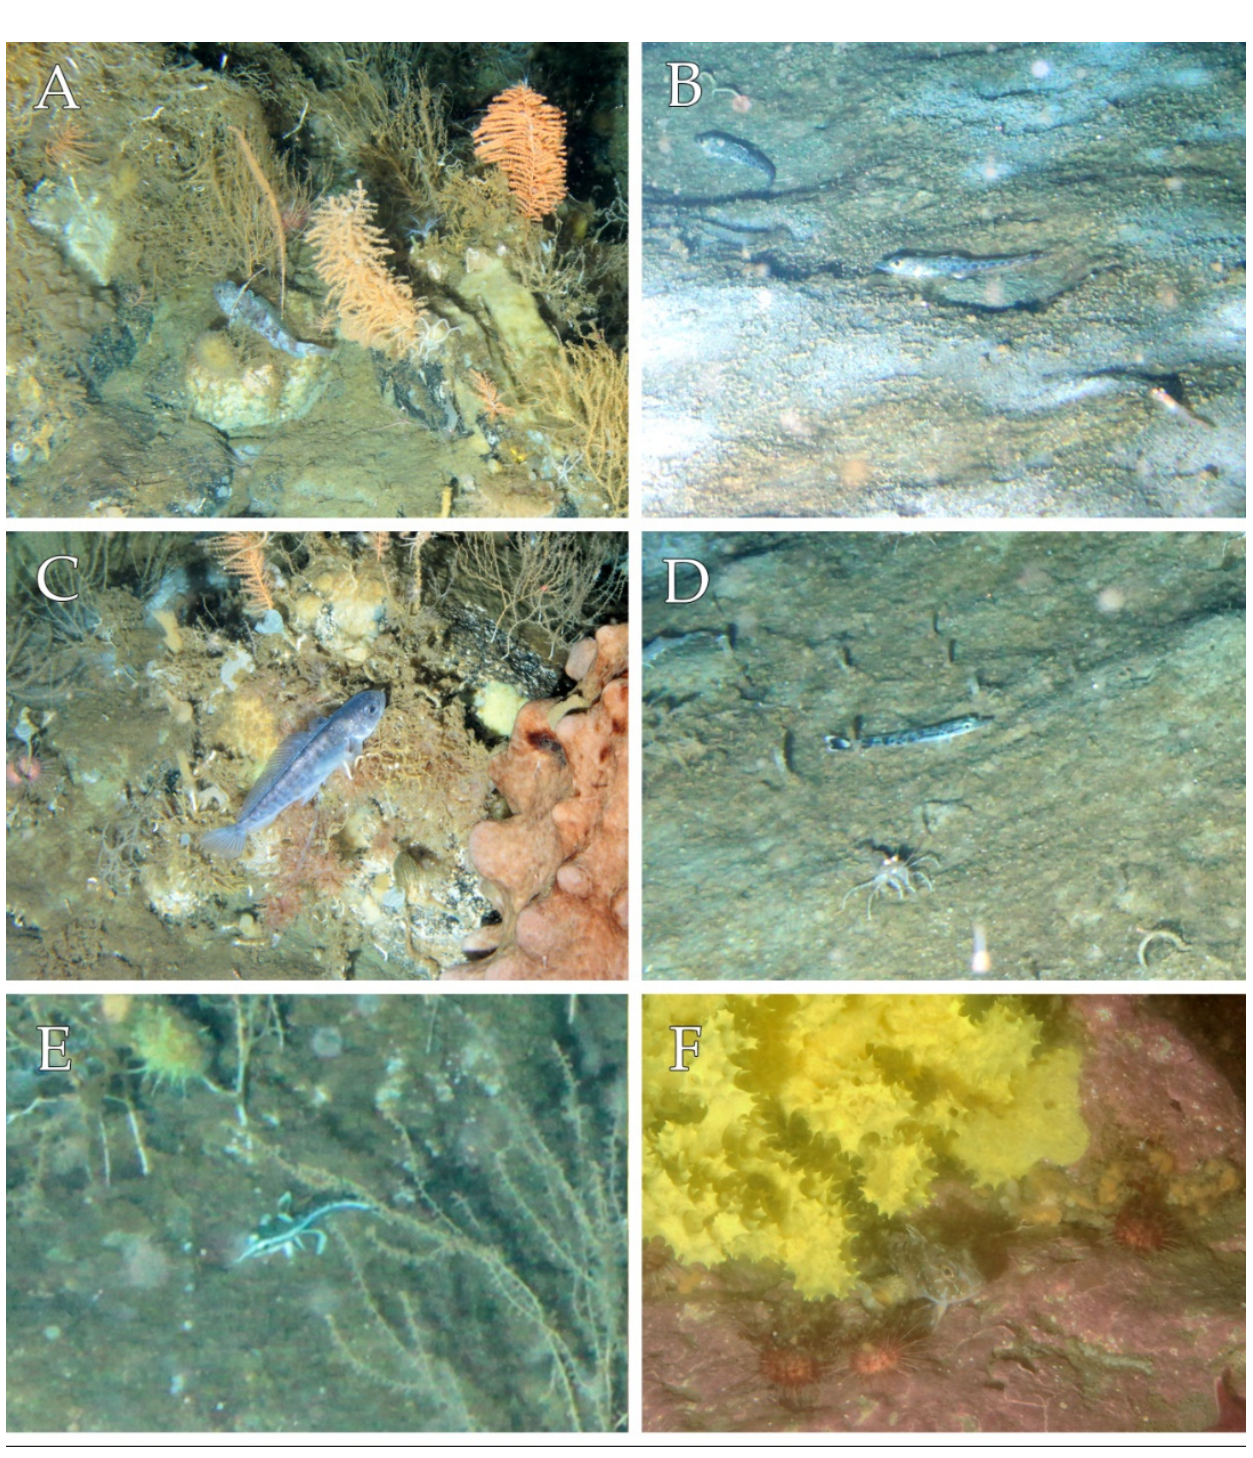
Figure 2. Box plot showing median, 25–75 percentiles, and maximum-minimum depth distribution of species along the transect Terra Nova Bay “Canyon” .